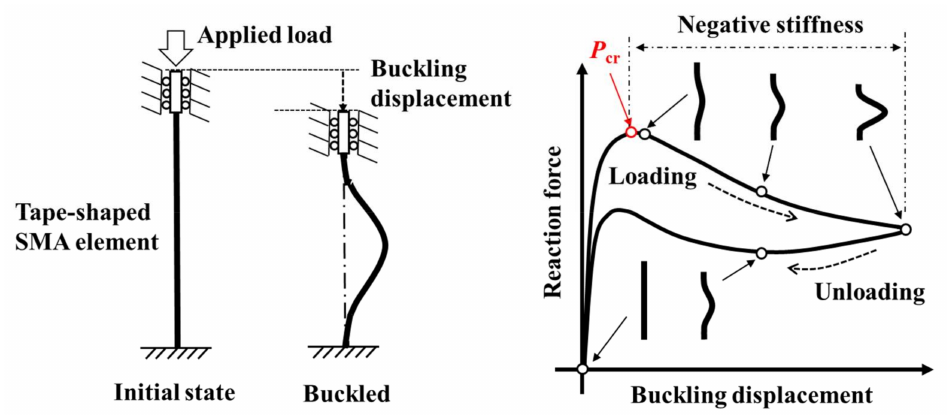
Figure 1. The relationship between reaction force and buckling displacement during buckling tests of a tape-shaped SMA